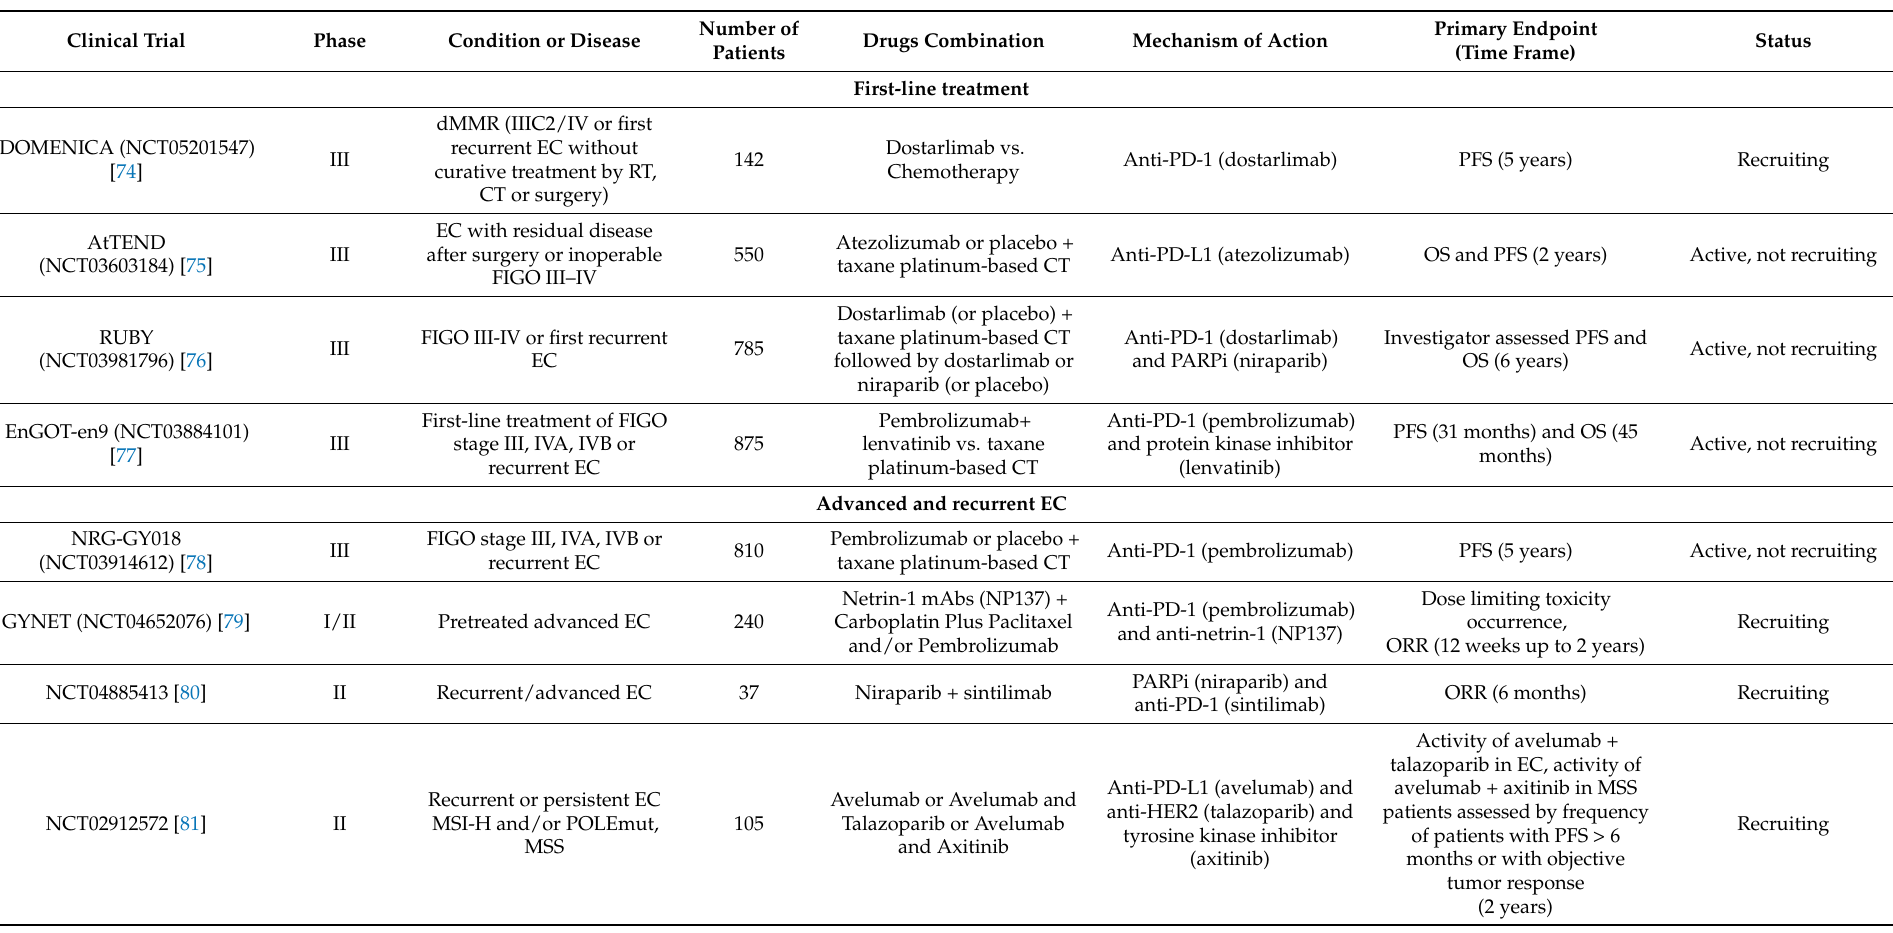
Table 5. Ongoing clinical trials testing immunotherapies alone or in combination in endometrial cancer. DC, dendritic cells; EC, endometrial cancer; FGFR, fibroblast growth factor receptor; FR α , folate receptor α ; HER2, Human Epidermal Receptor-2; IDO1, Indoleamine 2,3-dioxygenase; MDSC, myeloid-derived suppressor cells;